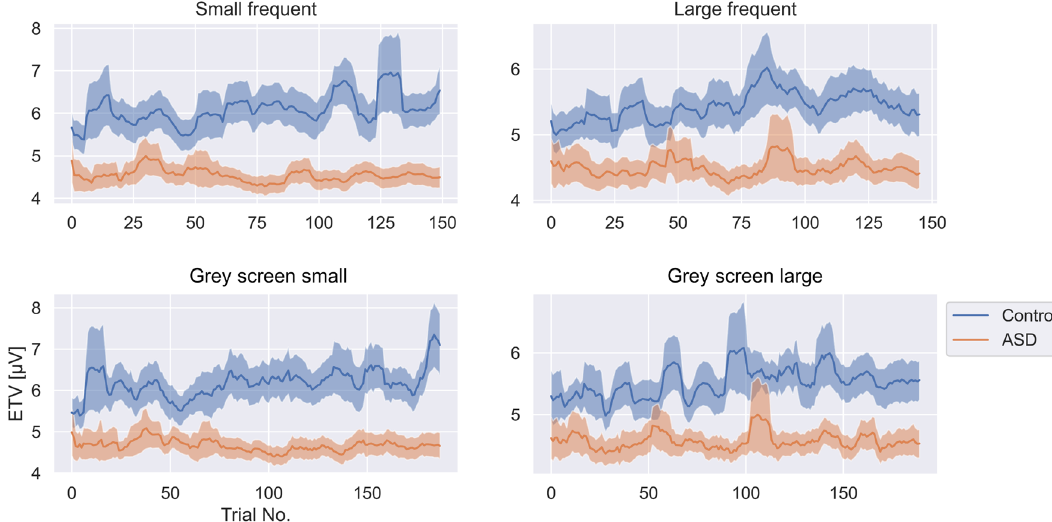
Figure 2. Evolving inter-trial variability. Blue traces show mean ETV of the control group, red traces show the mean ETV of the ASD group. Error shadings indicate group SEM. The ordinate shows the ordered trial number in the experiment. ETV is shown for small frequent and larger frequent checkers, as well as for the gray screens shown in the respective conditions. The bottom left graph depicts the ETV during the gray screen presentations in the small frequent/ large rare checkerboard condition. The bottom right graph shows the ETV during the gray screens in the large frequent/small rare checkerboard